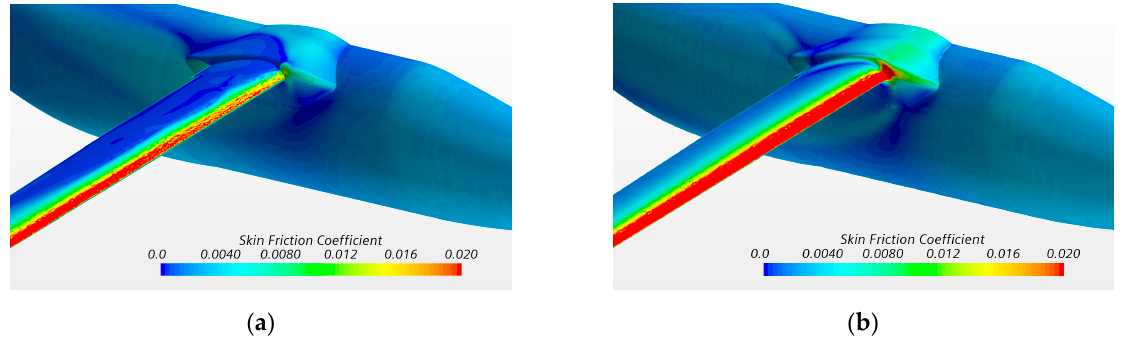
Figure 17. Effect of the wing–fuselage fillet on the flow separation (skin friction map), AoA equal to 14 deg. ( a ) Geometry without fillet. ( b ) Geometry with fillet.